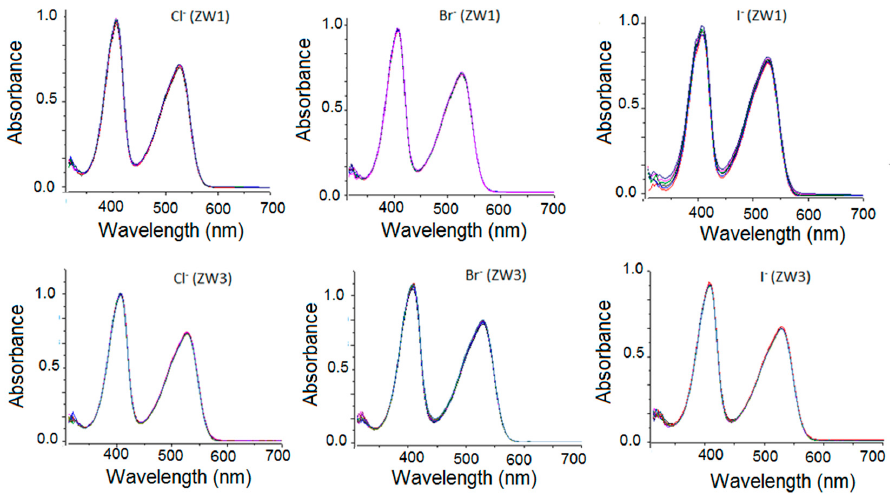
Figure 4. Spectrophotometric titrations (UV/vis absorption spectra) of ZW1 top three figures ([ ZW 1 ] ~ 6.0 × 10 − 5 M) and ZW3 bottom three figures ([ ZW 3 ] ~ 1.0 × 10 − 4 M) in acetonitrile with 10 mM acetonitrile